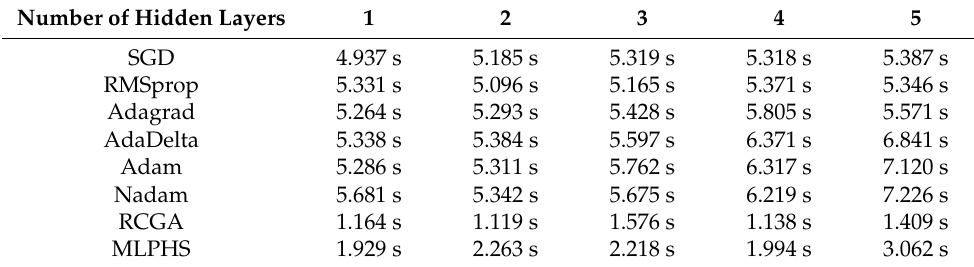
Table 4. Average time required for each optimizer according to the number of hidden layers.